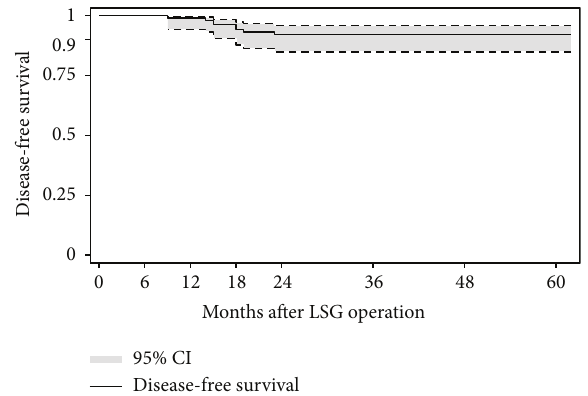
Figure 2: Kaplan-Meier survival estimate plot. Kaplan-Meier anal- ysis of patients subsequently requiring laparoscopic cholecystec- tomy after LSG due to symptomatic cholelithiasis. The biliary complication-free survival rates were 99.2% (95% CI, 94.4–99.9%) at 12 months, 94.4% (95% CI, 87.9–97.4%) at 18 months, and 92.2% (95% CI, 85.0–96.0%) at 24